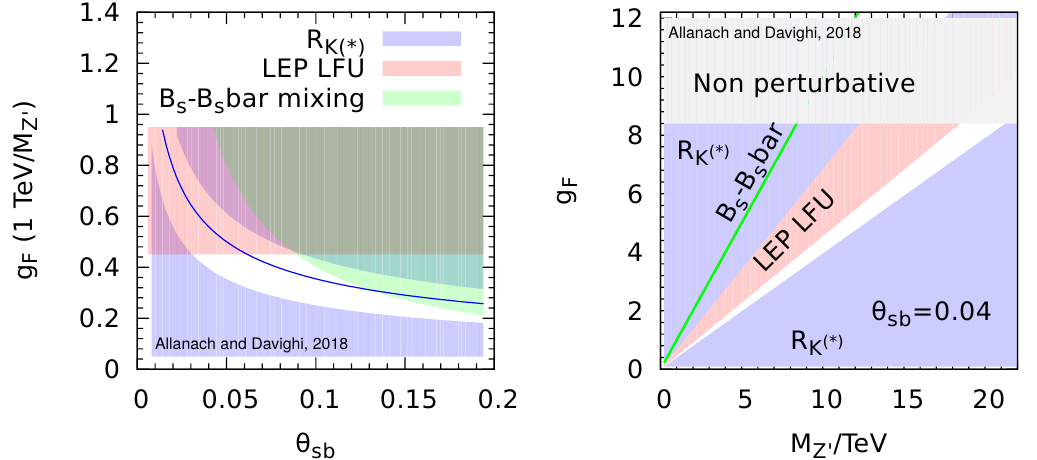
Figure 1 . Summary of 95% CL constraints upon the Third Family Hypercharge Model example case. Each constraint excludes the labelled coloured area, leaving an allowed white region. R refers to a (cid:12)t to ‘clean’ B (cid:0) physics observables [4], including to R K and R in the LH plot is where the (cid:12)t is central. ‘LEP LFU’ shows the LEP lepton (cid:13)avour universality constraint in eq. (3.11), whereas ‘ B s (cid:0) B s bar’ shows the constraint in eq. (3.5). In the right-hand plot, we show constraints in the g F (cid:0) M Z 0 plane for the choice (cid:18) sb = 0 : 04. In this plot, the region ruled out by the B s (cid:0) B s mixing constraint is above the line. The ‘Non perturbative’ region is de(cid:12)ned as the region where (cid:0) Z 0 > M Z 0 and is estimated in section